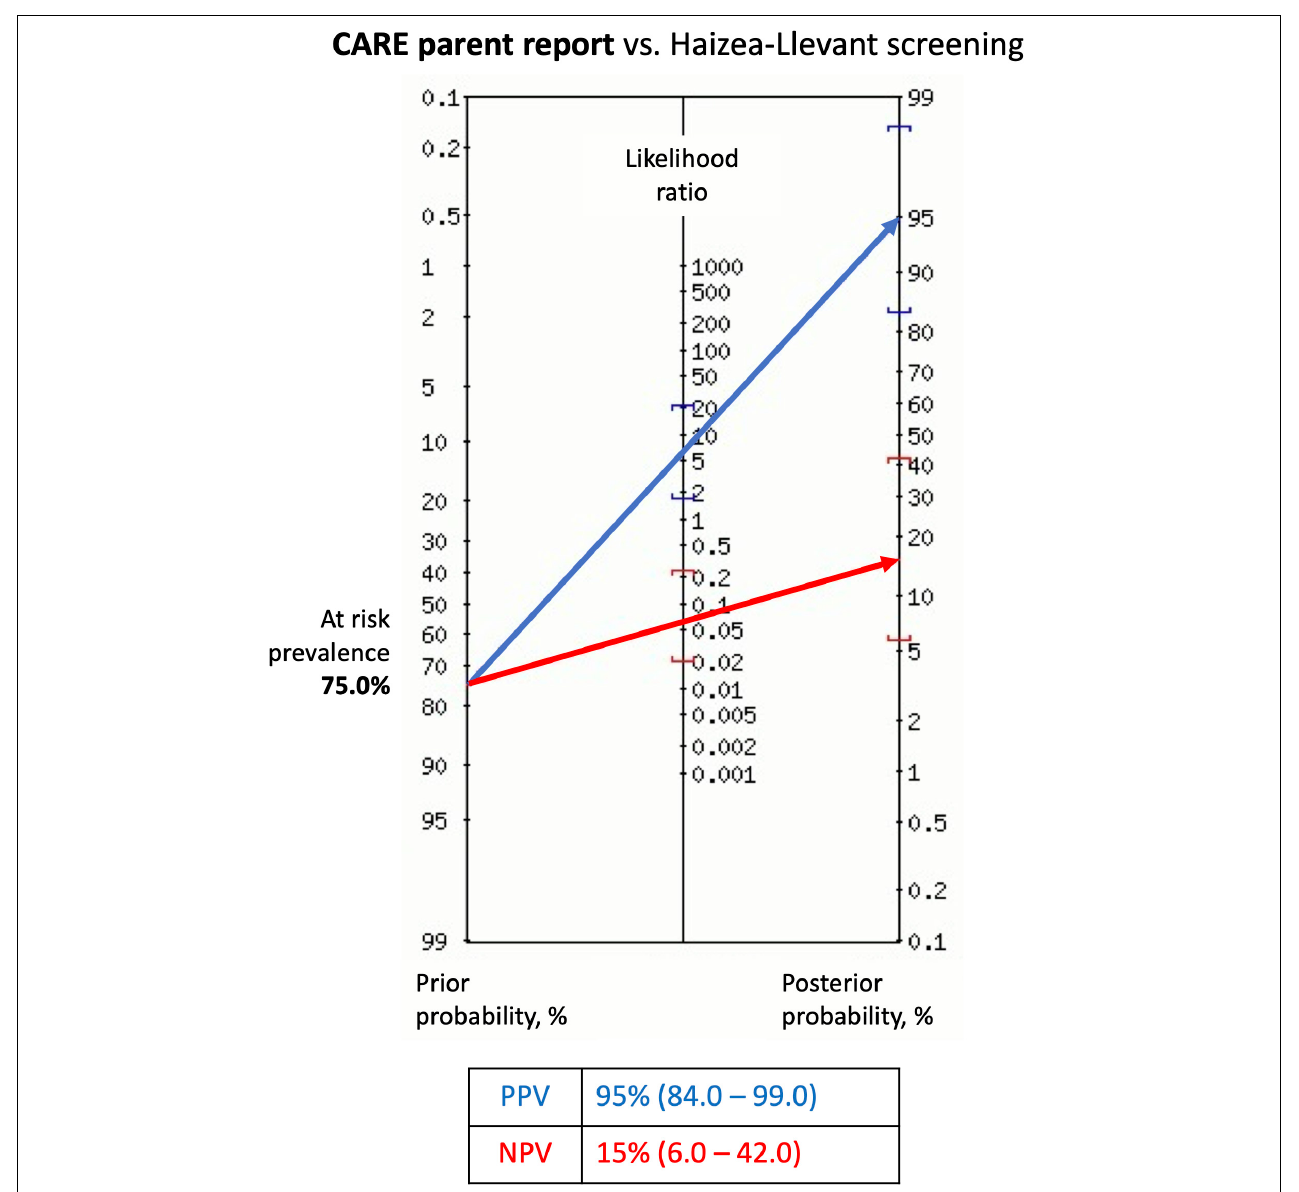
FIGURE 4 | Fagan’s nomogram showing probability of children At risk after parents report using CARE booklet. Probabilities were calculated based on the screening with Haizea-Llevant table (HLL). Positive At risk diagnosis (blue arrow) refers to typical or non-specific appearance, and Not at risk diagnosis (red arrow) to atypical or negative appearance in CARE. Precision is given as 95% confidence interval. Risk prevalence is derived from the number of At risk positive and Not at risk participants after screening with HLL. LR+, positive likelihood ratio; LR–, negative likelihood ratio; NPV, negative predictive value; PPV, positive predictive